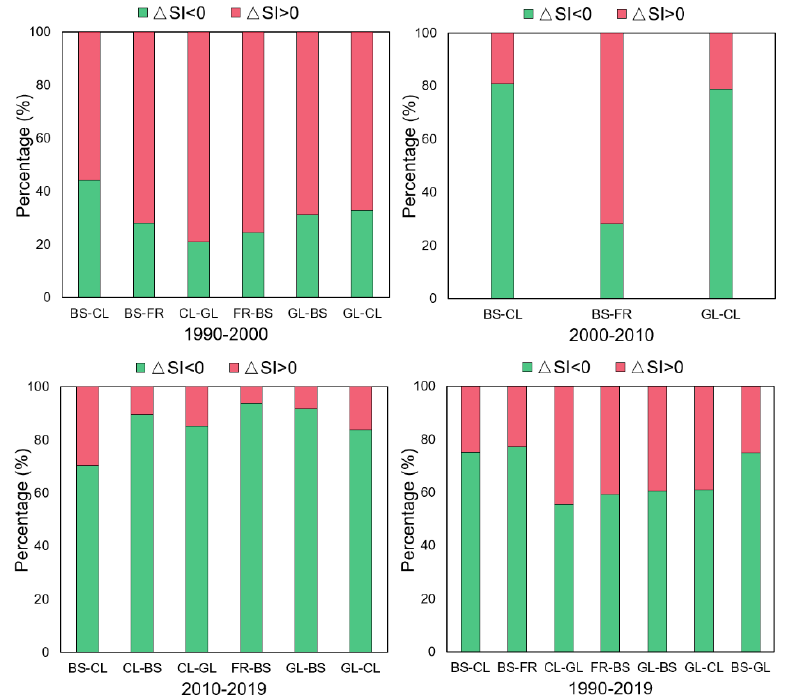
Figure 11. The percentage of ∆ SI area for the land use categories that changed during the study period. ∆ SI: the salinity index (SI) of the next year minus the SI of the previous year. BS–CL: bare soil to cropland; BS–FR: bare soil to forest; CL–GL: cropland to grassland; FR–BS: forest to bare soil; GL–BS: grassland to bare soil; GL–CL: grassland to cropland; BS–GL: bare soil to grassland.